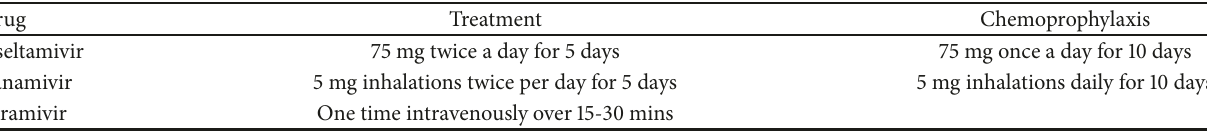
Drug Treatment Chemoprophylaxis Oseltamivir